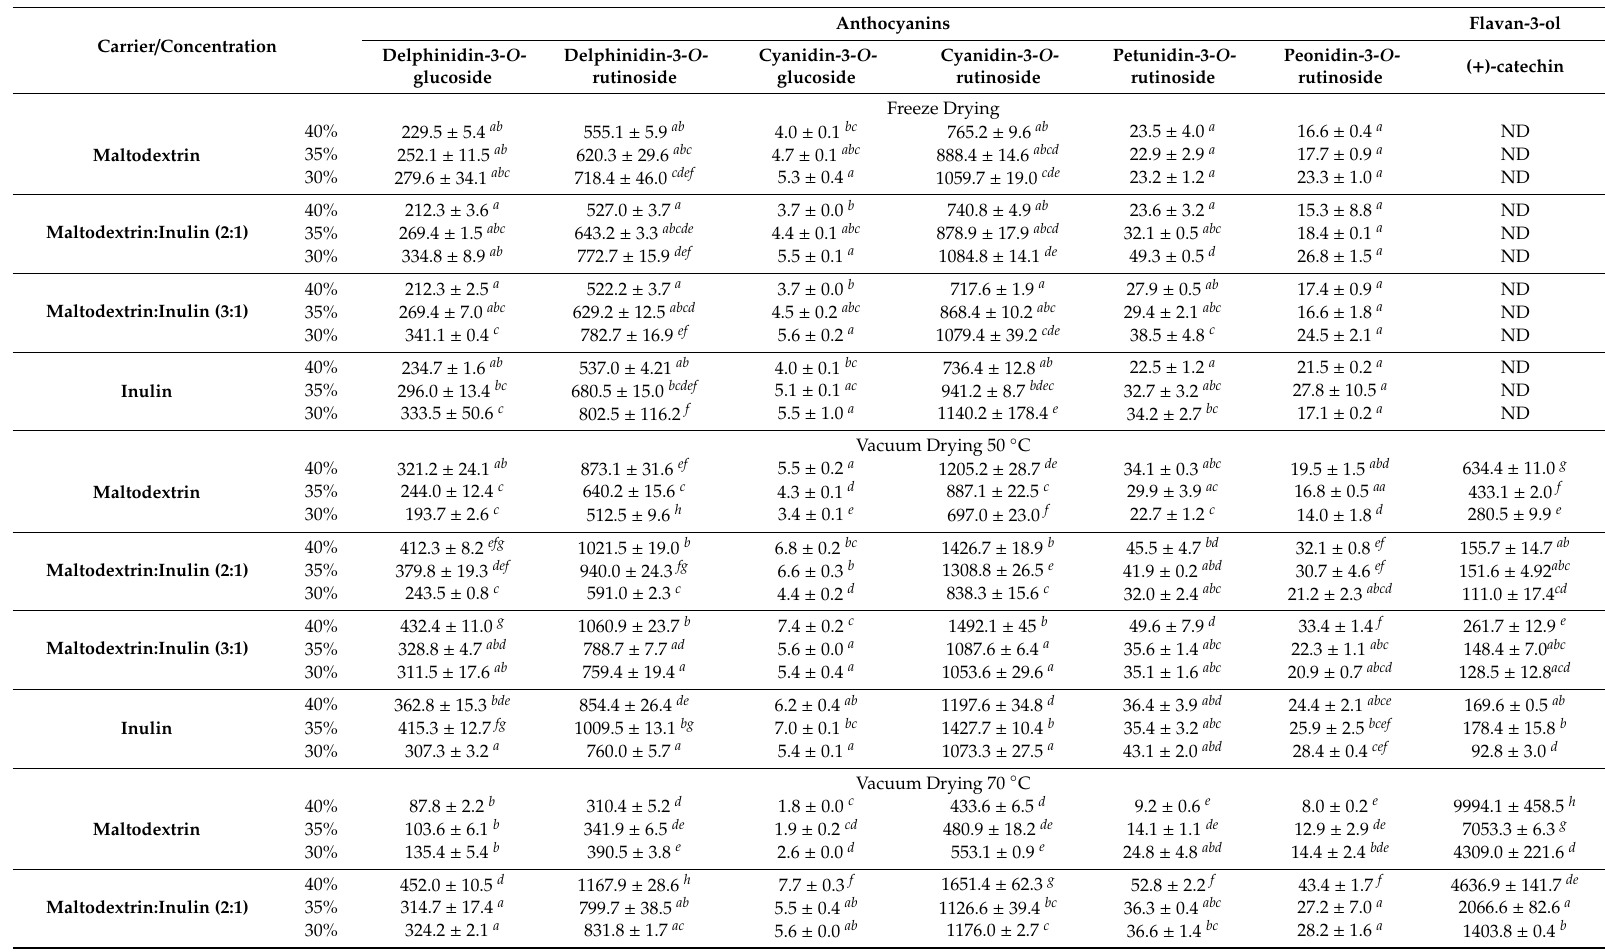
Table 1. The content of anthocyanins (mg / kg db) identified in blackcurrant juice powders made with the addition of maltodextrin, inulin, and a mixture of maltodextrin–inulin using di ff erent drying methods (average ± SD; n =